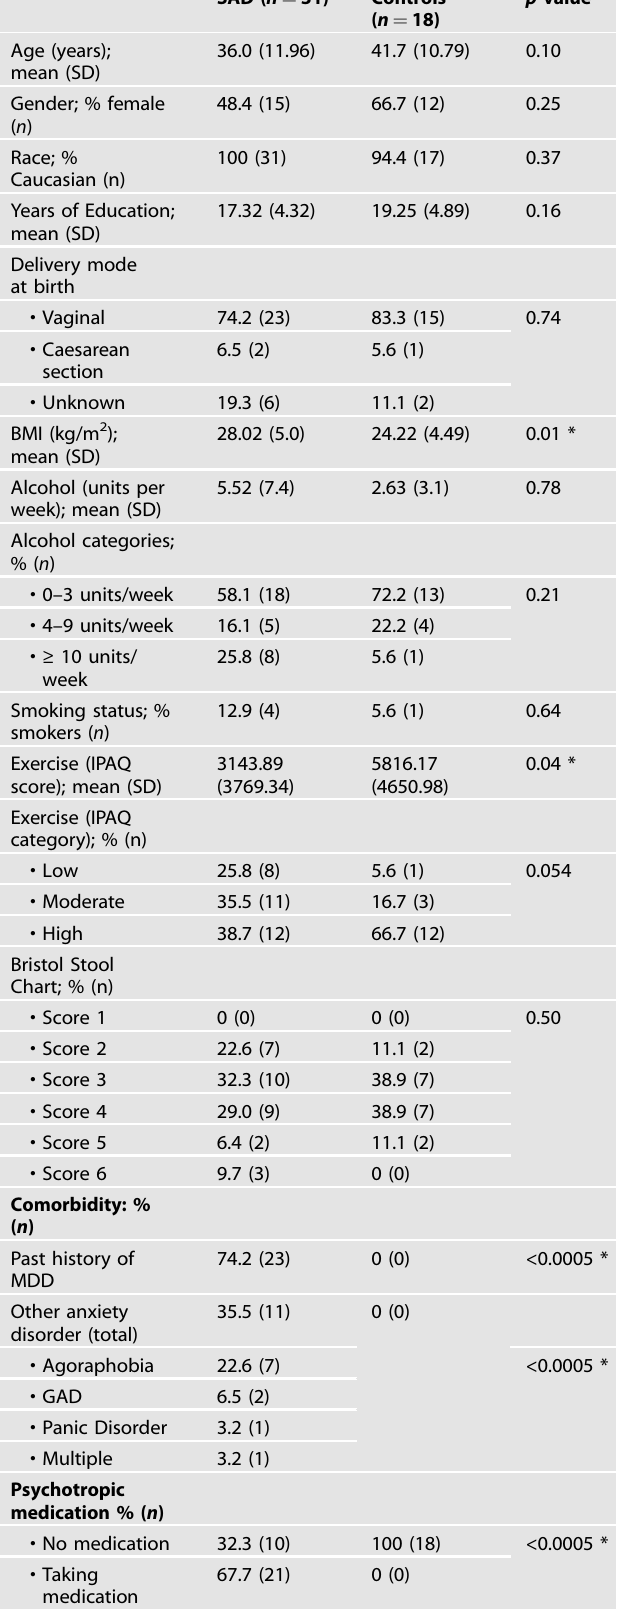
Table 1. Demographic Characteristics and Psychological